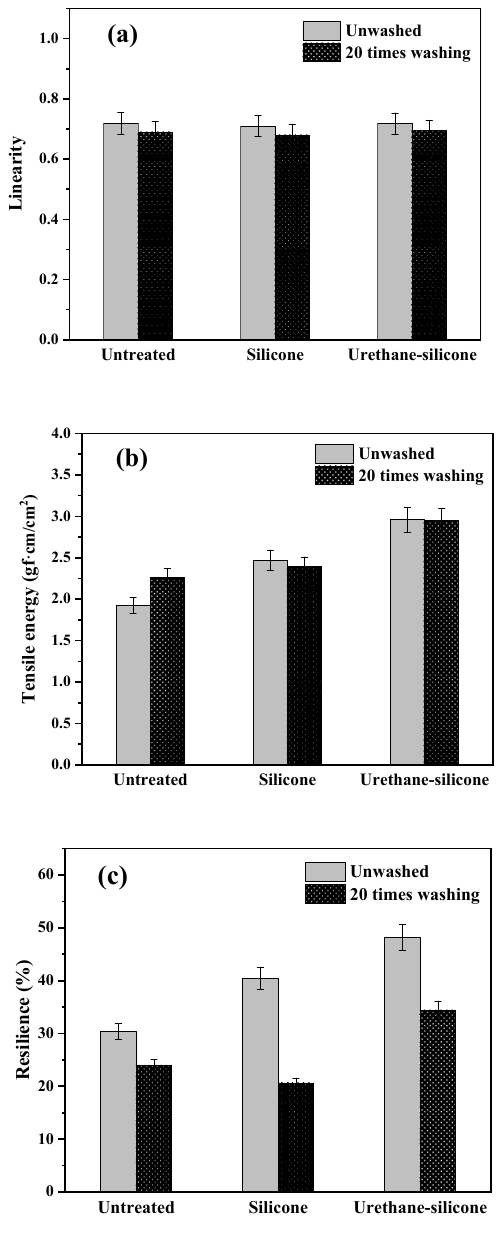
Figure 8. Tensile properties of the cotton knit fabric untreated and treated with softeners. ( a ) Linearity; ( b ) tensile energy; ( c )